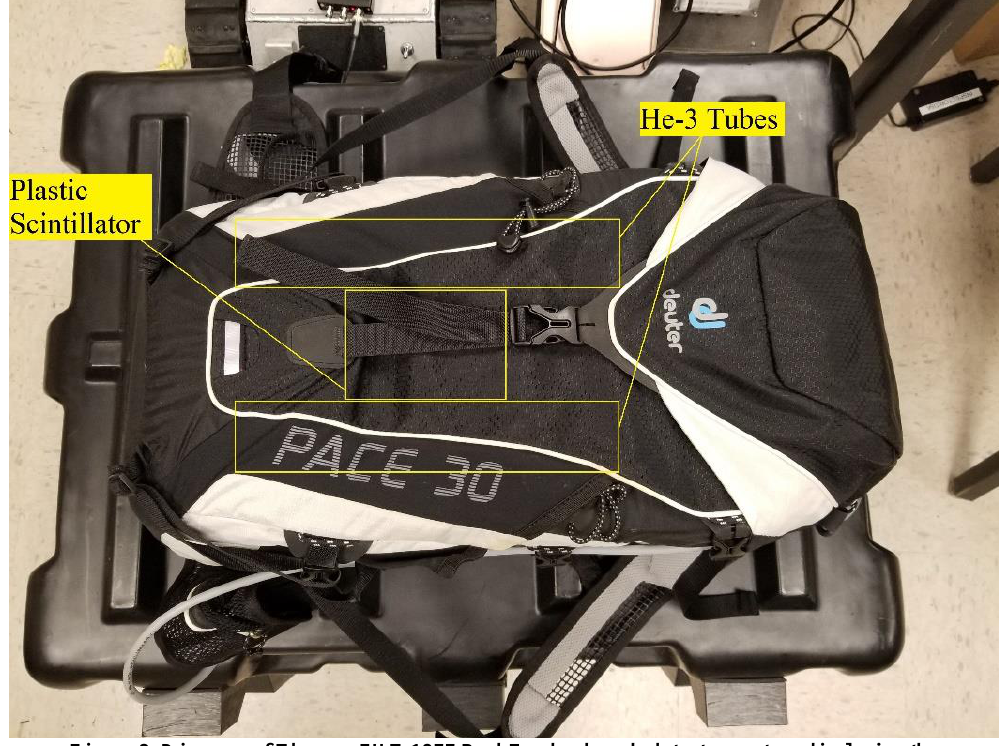
Figure 3. Diagram of Thermo FHT 1377 PackEye backpack detector system displaying the approximate positions of the plastic scintillator detector and the two 3 He tubes.